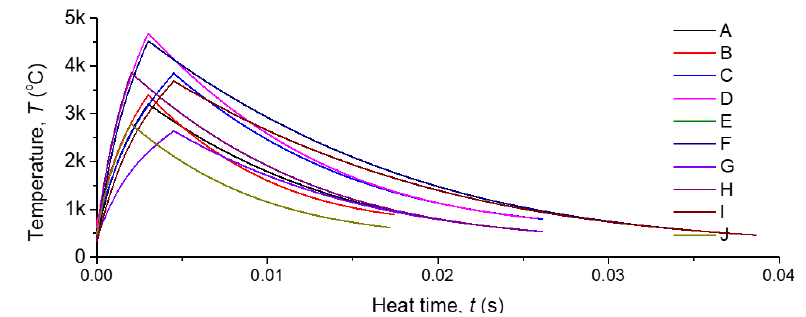
Metals 2019 , 9 , x FOR PEER REVIEW Figure 8. Temperature curve induced within a heat pulse duration. Figure 8. Temperature curve induced within a heat pulse duration.